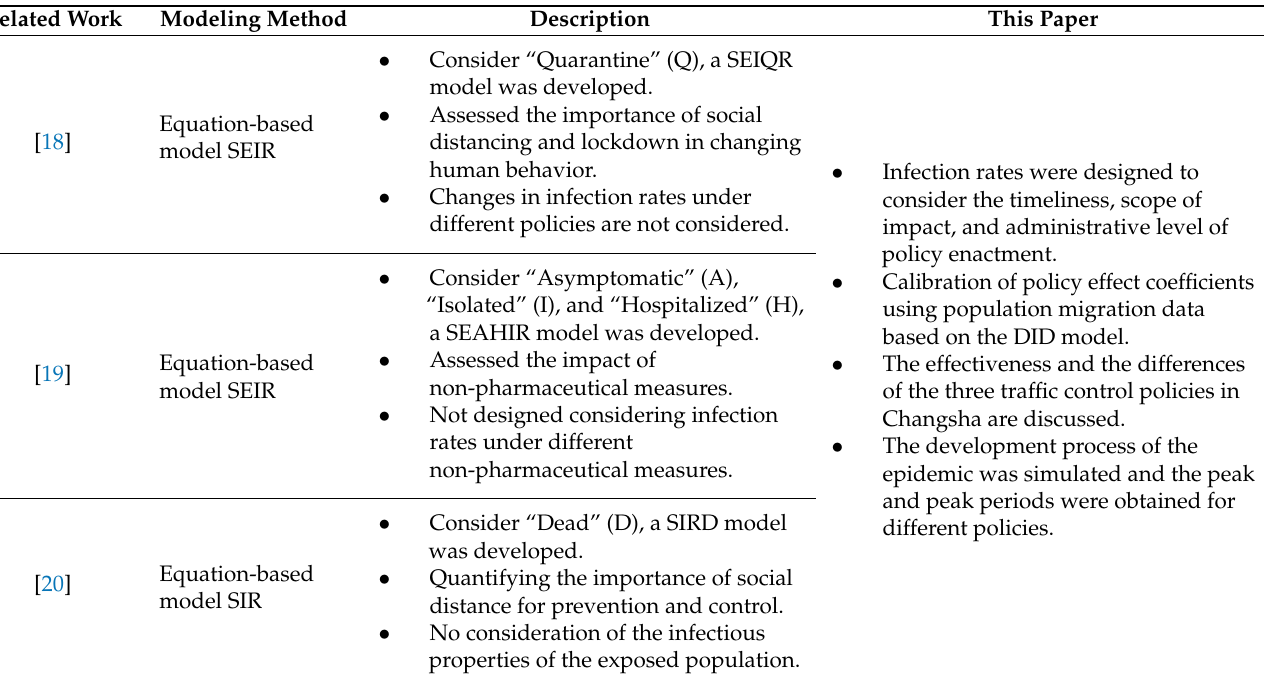
Table 1. Related work on policy evaluation